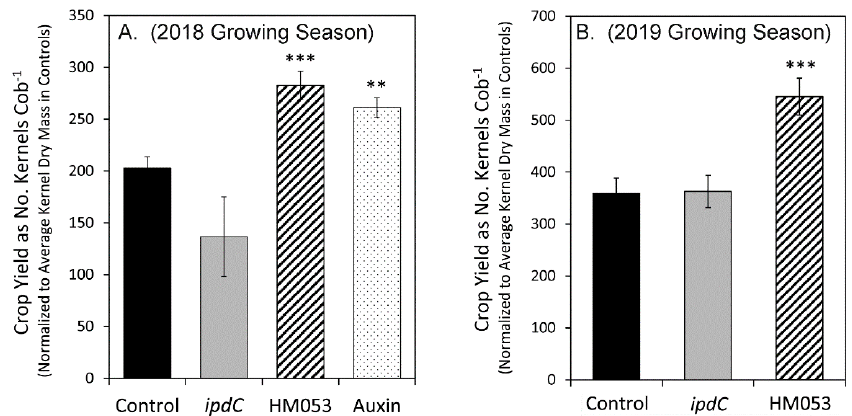
Figure 4. E ff ect of treatment on corn seed yield. Seed yield was quantified as number of kernels per cob. In both the 2018 and 2019 seasons, plants inoculated with A. brasilense HM053 bacteria showed significantly enhanced kernel yields compared to control treatments. Chemical auxin treatment showed significantly enhanced kernel yield as well, while A. brasilense ipd C and control maize were not significantly di ff erent in yield from one another. Data was normalized to the average dry kernel mass in controls and reflect N = 12 biological replicates for each treatment. Panel A: data from the 2018 growing season; Panel B: data from the 2019 growing season). Error bars indicate ± SE. Paired comparisons were made using the Student t-tests between single treatments and non-inoculated control plants. Asterisks indicate significant di ff erences (** p < 0.01, *** p < 0.001) in these comparisons.